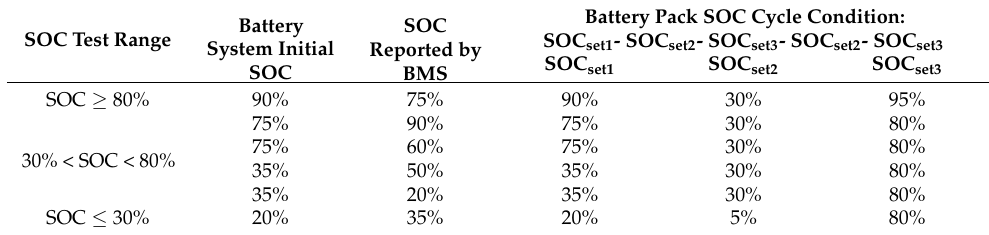
Table A2. Parameter setting for SOC correction speed